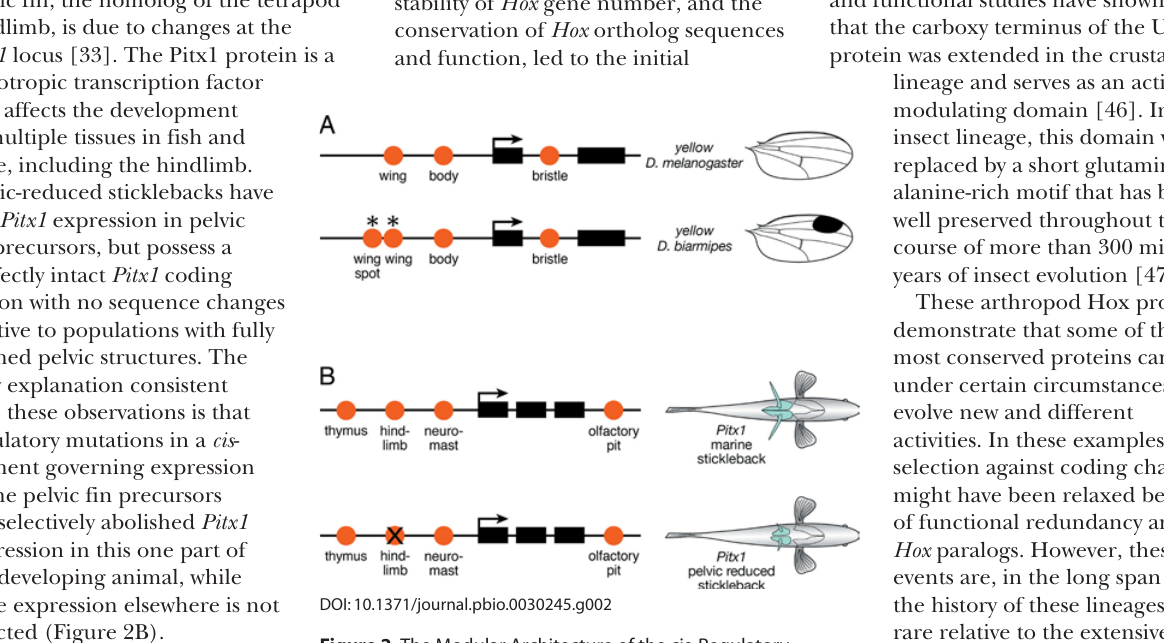
Figure 2. The Modular Architecture of the cis-Regulatory Regions of Pleiotropic Genes Enables the Independent Evolution of Gene Expression in Different Body Parts (A) Expression of the yellow pigmentation gene of Drosophila is controlled by several different cis-regulatory elements (red circles). Differences in the activity of selected elements (wing and wing spot) underlie differences in pigment patterns between species (Figure based on [35].) (B) Similarly, the expression of the Pitx1 gene of vertebrates is inferred to be controlled by multiple elements (red circles). In pelvic-reduced stickleback fi sh, Pitx1 expression is absent from the pelvic region. This is proposed to occur through of a selective loss of activity of the hindlimb regulatory element (cross through the red circle) (Figure based on